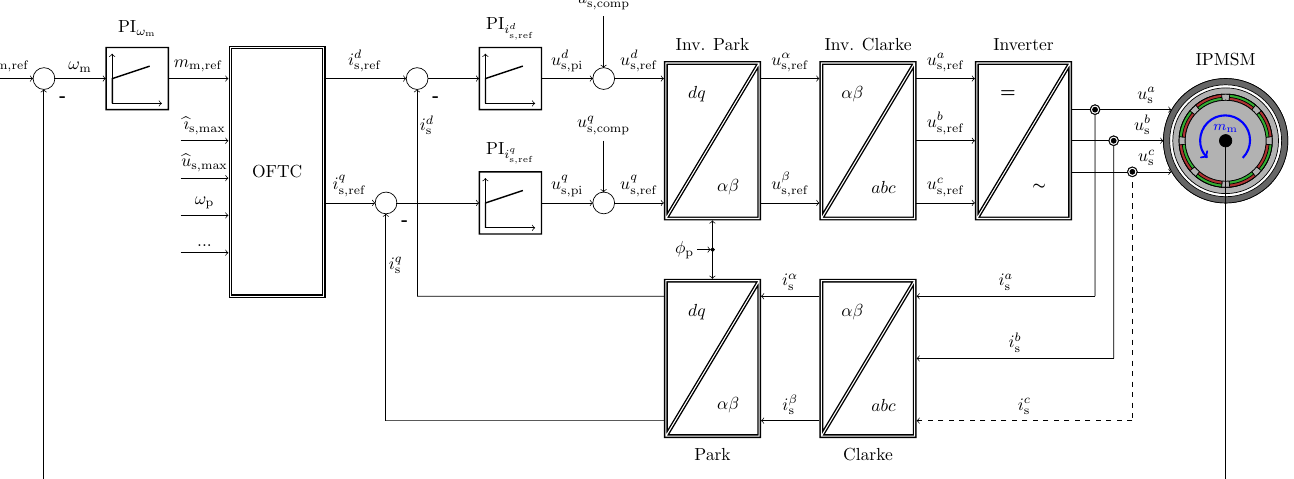
Figure 2. Block diagram of the control system with OFTC and underlying current controllers of a typical electrical drive system consisting of IPMSM and